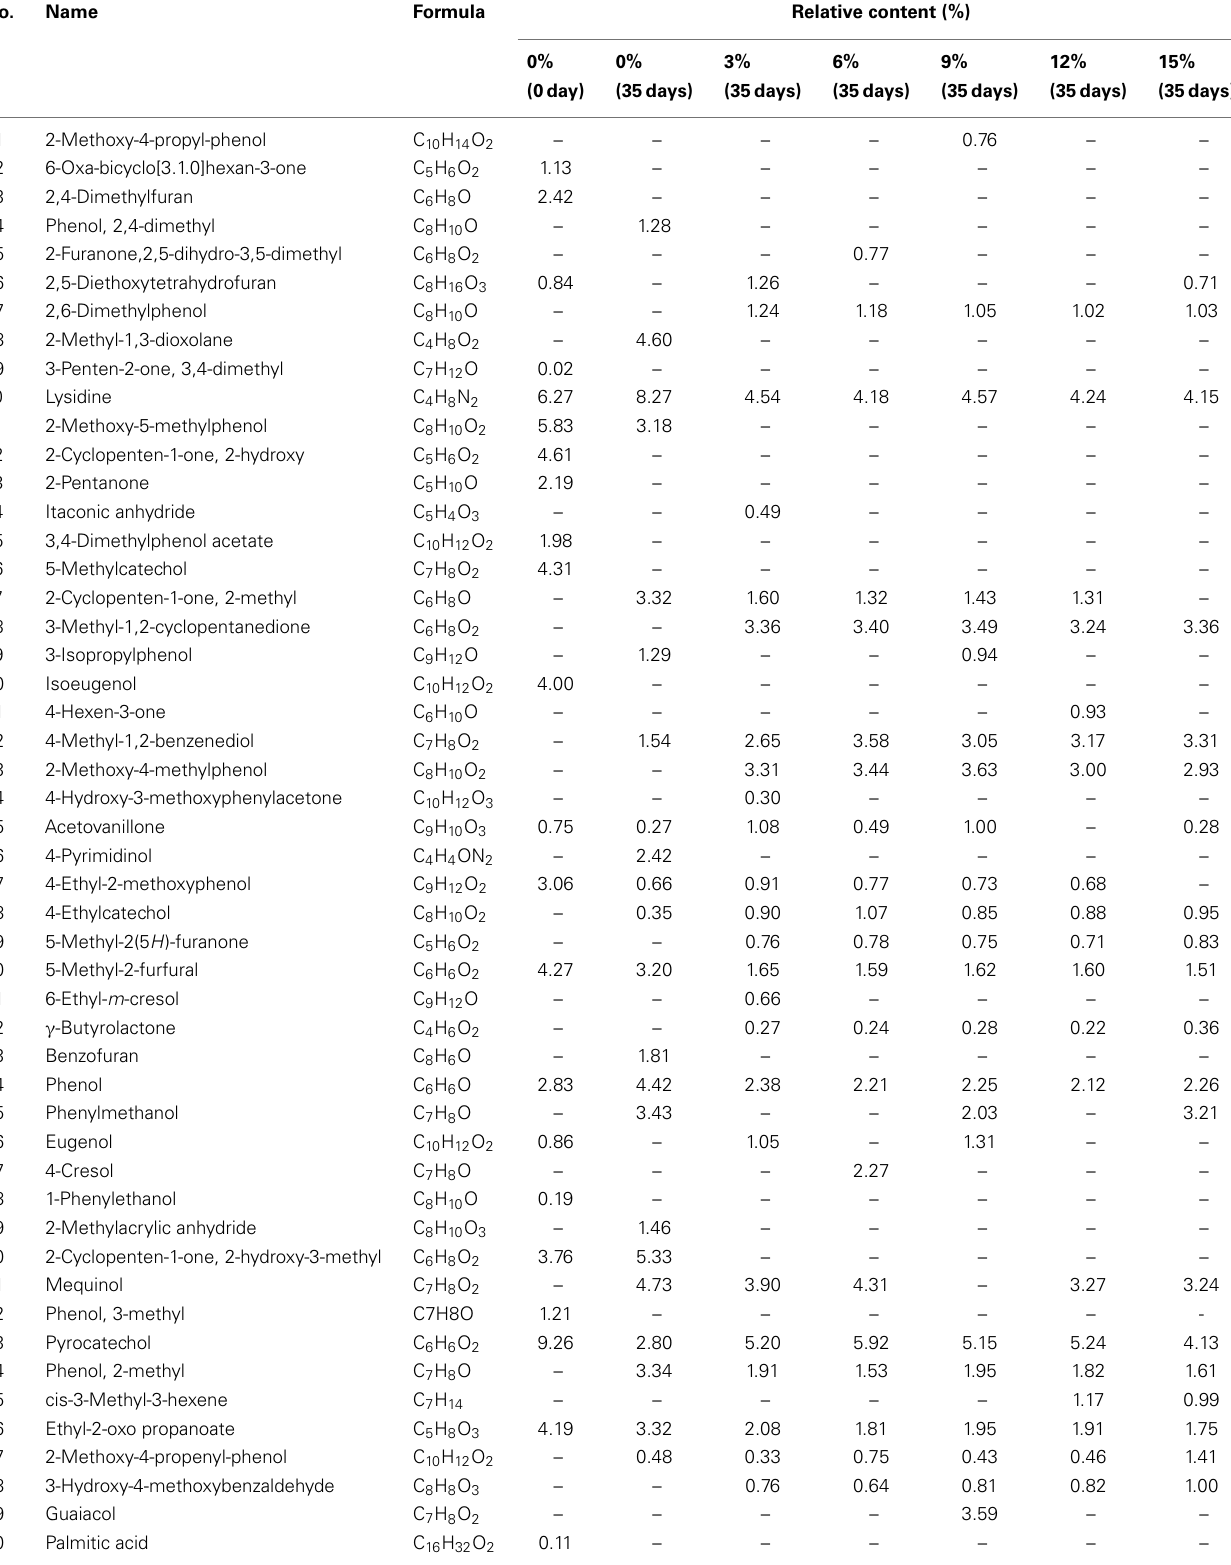
Table 1 | GC–MS analysis of bio-oils with different content of ethyl acetate